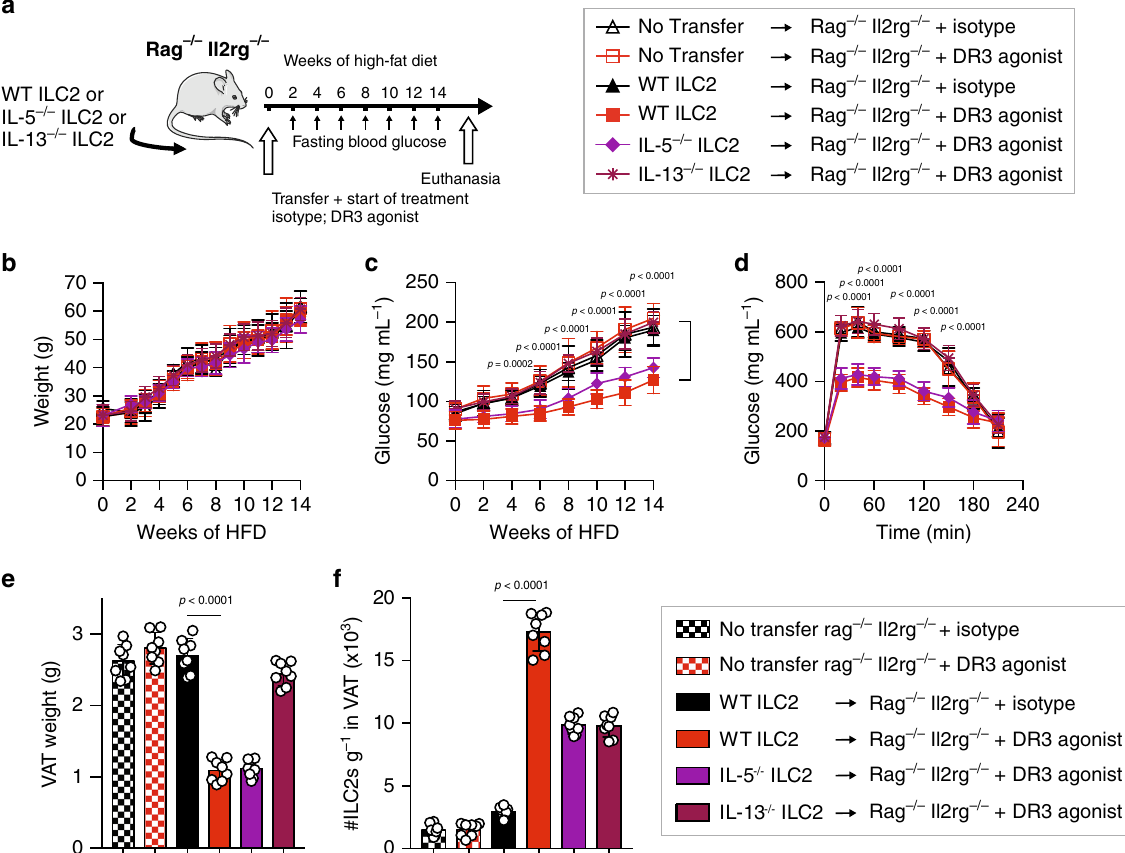
Fig. 5 The therapeutic effects of DR3 are dependent on expression on ILC2s and IL-13. a A cohort of Rag − / − Il2rg − / − mice were adoptively transferred with ILC2s from either WT, Il5 − / − or Il13 − / − mice, n = 8 mice. Moreover, two additional mice cohorts did not receive any ILC2s. Subsequently, mice were placed on HFD for a period of 14 weeks and were intraperitonially treated with either DR3 agonist or isotype control as shown in the timeline. b Total weights were measured once a week, and c fasting blood glucose levels were measured once every two weeks for a period of 14 weeks. d Glucose tolerance test was performed on the 14th week. e the weight of VAT was determined, and f the number of ILC2s per gram of VAT was quanti fi ed after 14 weeks. Error bars are the mean ± SD. Statistical analysis, one-way ANOVA ( b – d ), two-tailed student ’ s t -test ( e , f ); ns: non-signi fi cant. Mouse image provided with permission from Servier Medical